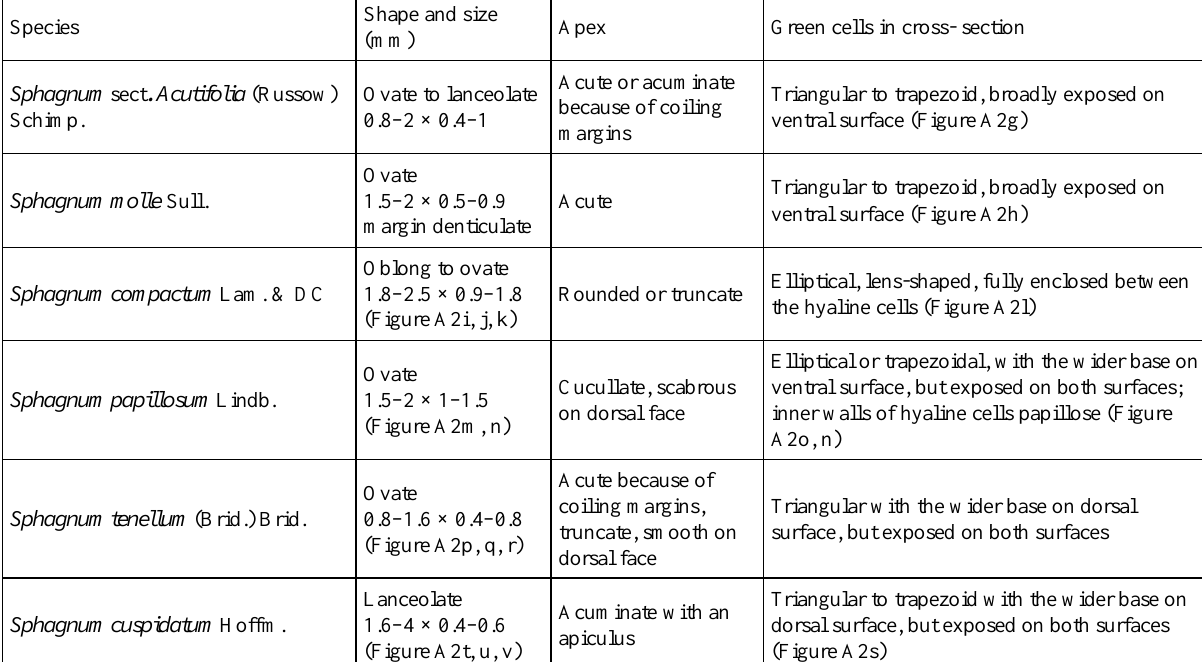
Table A2. Diagnostic characteristics for mosses : Sphagnum spp . branch leaves (Figure